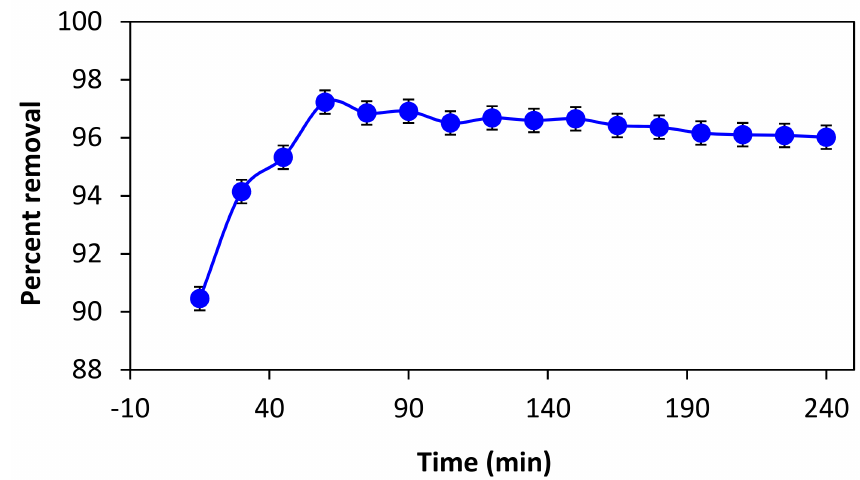
Figure 2. Effect of contact time on percent removal of dye.